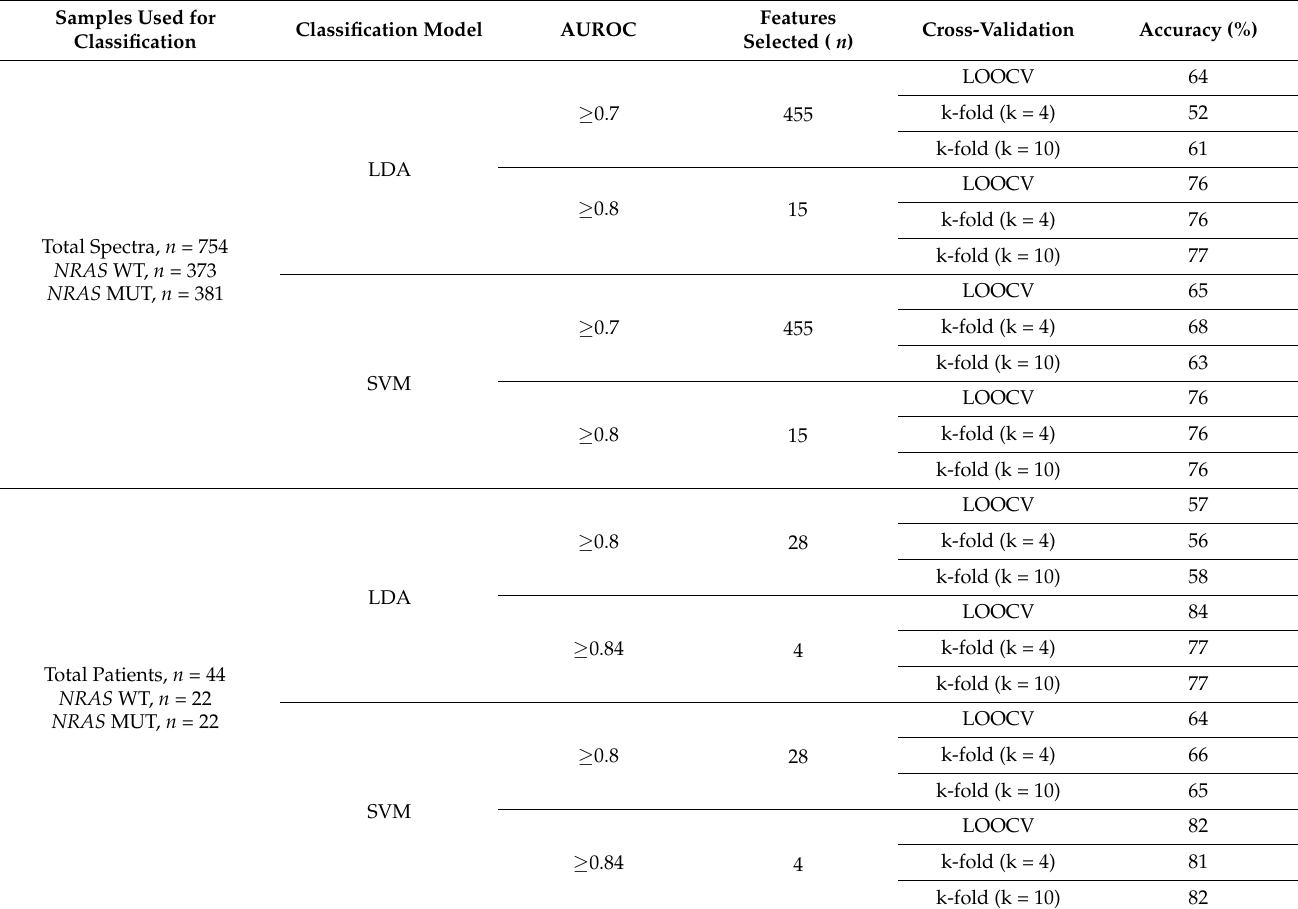
Table 3. Classification analysis to discriminate NRAS (neuroblastoma RAS viral oncogene